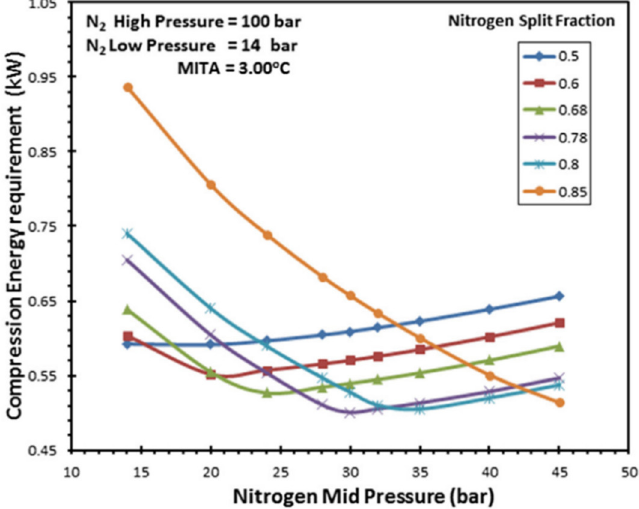
Reproduced with permission from Elsevier (license number 5413360697553). Figure 17. Middle-pressure optimization in the dual nitrogen expander process [57].